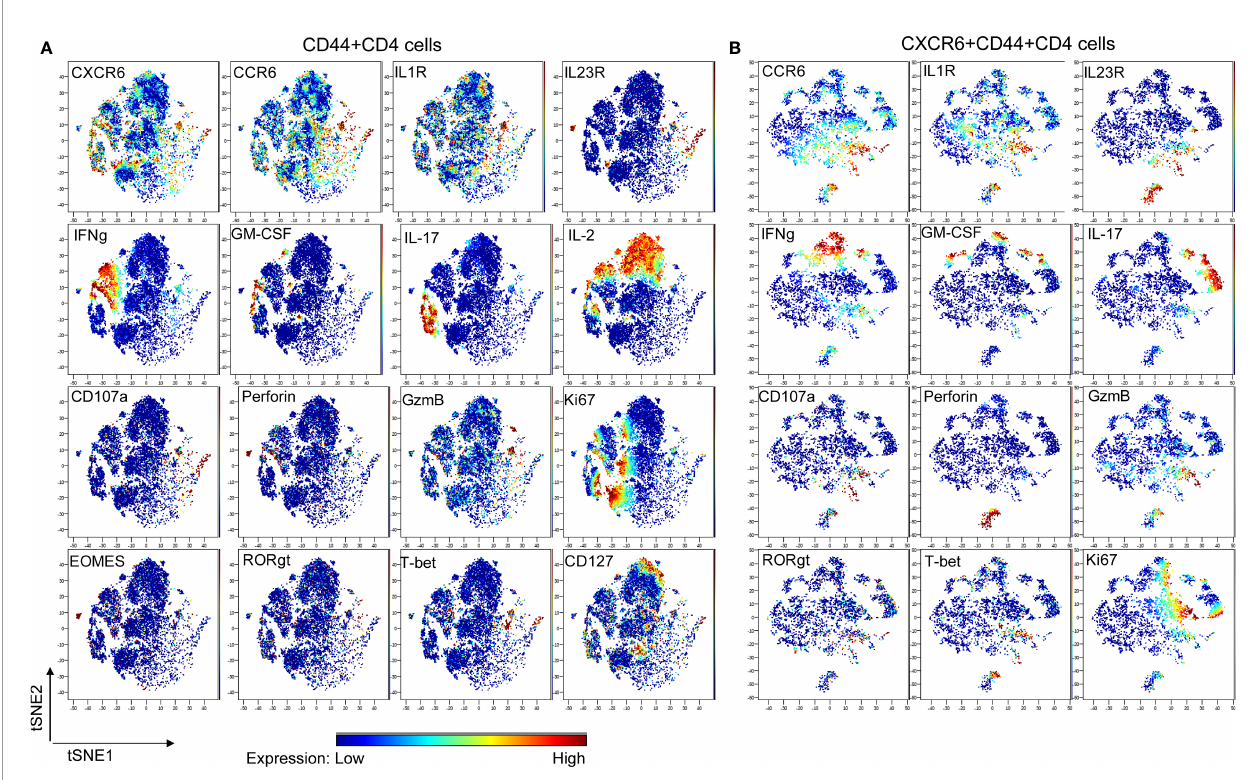
FIGURE 2 | CyTOF study. Wt mice were induced to develop EAE and sacri fi ced at the disease onset (N = 9; dLN from every 3 mice were pooled and deemed as one biological sample). Lymphocytes were stimulated with PMA & Ionomycin for 4 h in the presence of Brefeldin A, then were stained with metal-conjugated mAbs and subjected to CyTOF analysis. CXCR6 mAb and CD107a mAb were added during the stimulation. Shown are viSNE plots of CyTOF of effector CD4 (A) and CXCR6 + effector CD4 (B) of one of 3 biological samples with the same pattern. The color indicates expression level of labeled